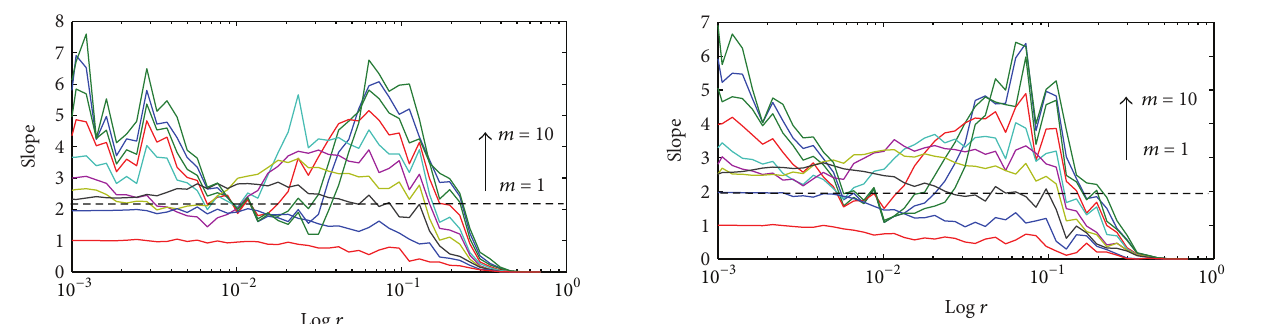
Figure 5: Local slope of correlation sum by lateral vibration time series.